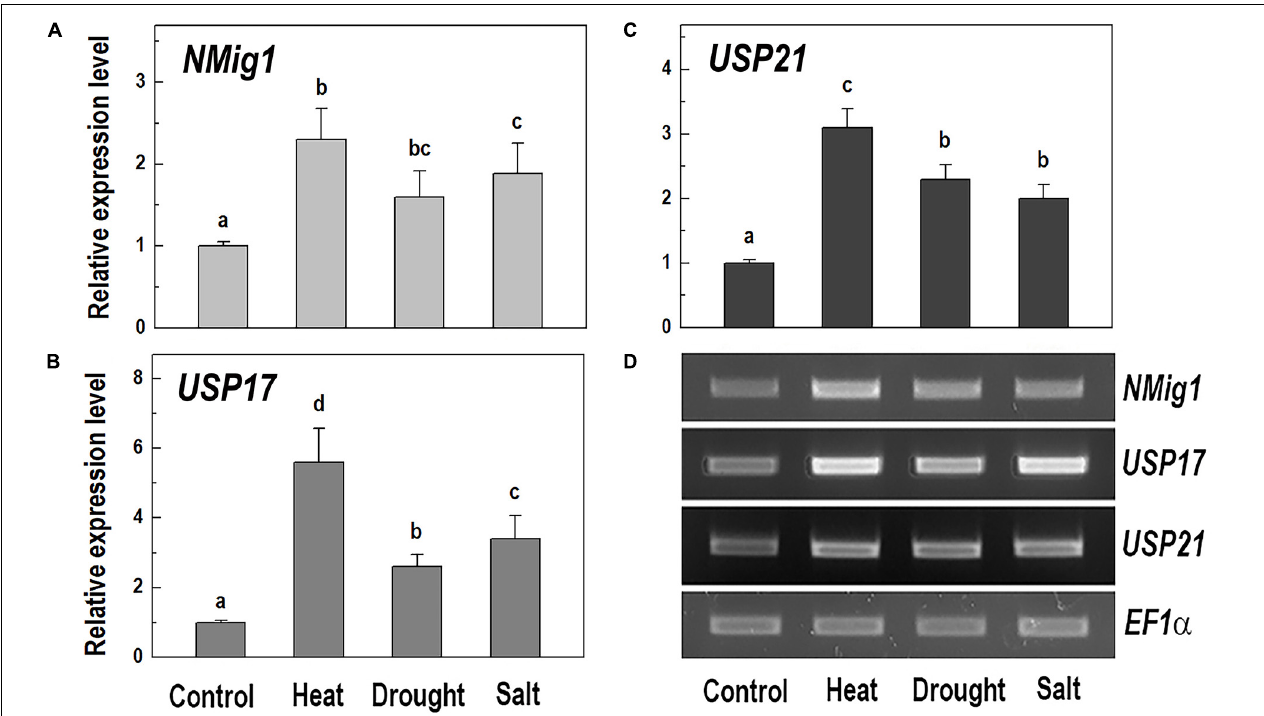
FIGURE 4 | Quantitative RT-PCR (A–C) and semi-quantitative RT-PCR analysis (D) of the expression levels of NMig1 (A) , and the universal stress proteins USP17 (B) , and USP21 (C ) in 10-day-old wild-type seedlings subjected to heat shock, drought and high salinity. Expression levels were normalized to those of EF1a and CDKA1;1 , as described in Materials and Methods. For semi-quantitative RT-PCR analysis EF1 α was used as a reference gene. Data represents the mean values ± SE from at least three biological replicates. Different lowercase letters indicate statistically significant difference ( p ≤